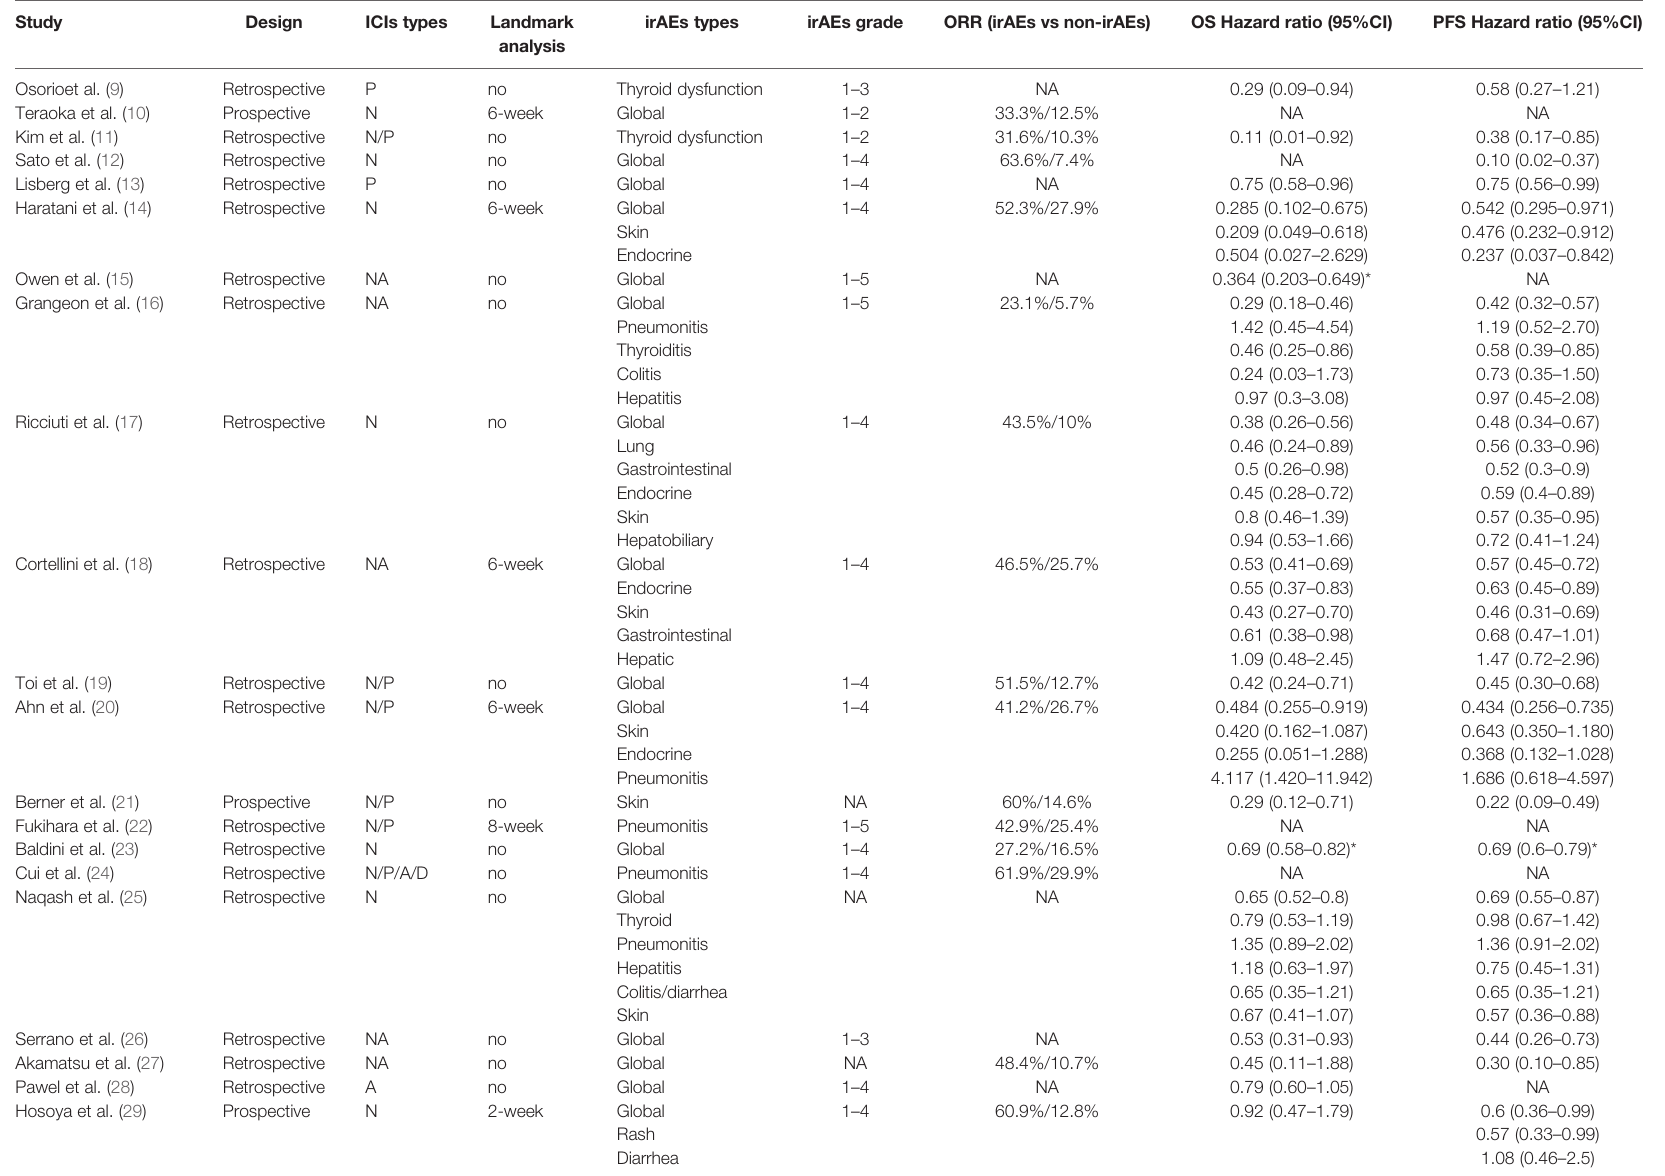
TABLE 1 | Main characteristics of the included